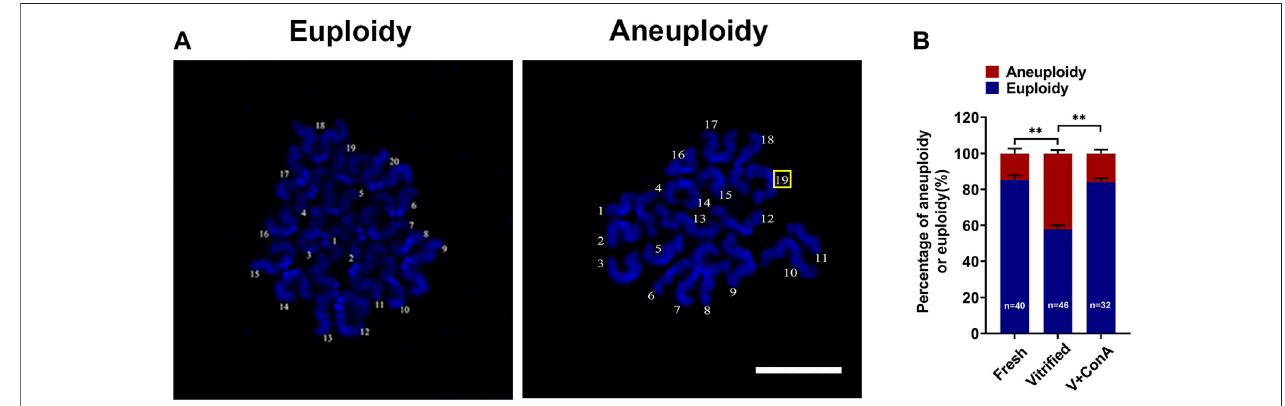
FIGURE6| Increasingcorticaltensionattenuatedaneuploidyrateinvitri fi edoocytes. (A) Representativeimagesofeuploidyandaneuploidy.Scalebar=25 μ m. (B) Rateofeuploidyandaneuploidyoocytesinthefresh( n =40),vitri fi ed( n =46)andV+ConA( n =32)groups.Datawerepresentedasmeanpercentage(mean±SEM)ofat least three independent experiments. * p < 0.05, ** p < 0.01, *** p <